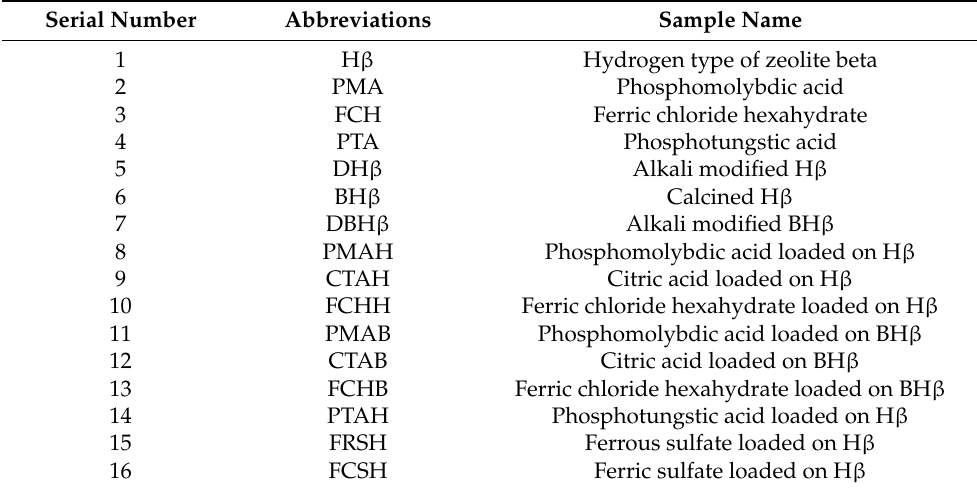
Table 1. The various solid acid catalysts prepared in this study are listed in the table with their corresponding serial number and